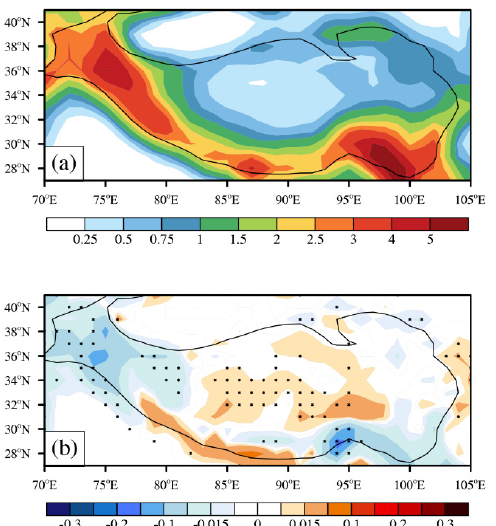
Figure 3. ( a ) Climatology (units: N m − 2 ) and ( b ) trend (units: N m − 2 decade − 1 ) of the SWMF over the TP during 1979–2017. The black contour denotes the isoline of 3000 ‐ m elevation. The dots in ( b ) indicate significant trends at 95% confidence level using the student ‐ t test.